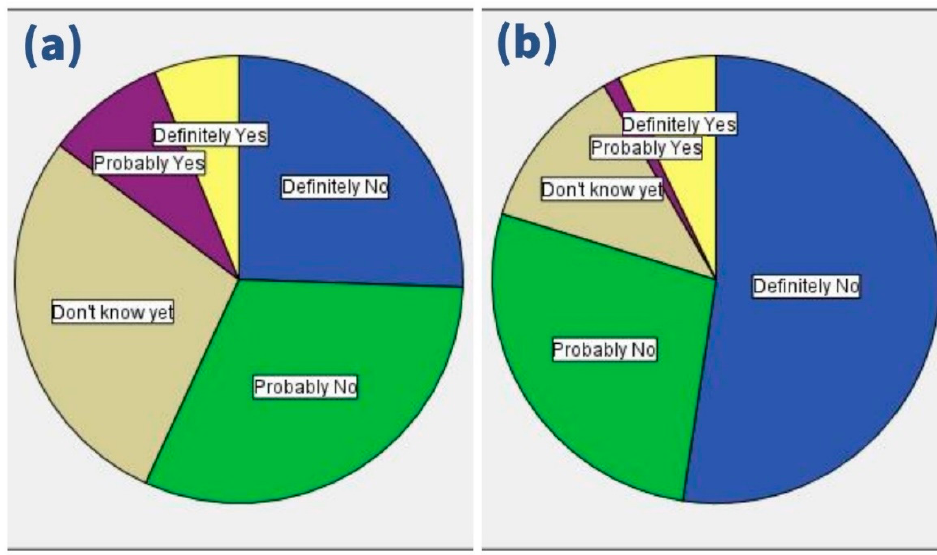
Figure 4. Response of ( a ) pregnant women and ( b ) lactating women to physician’s recommendation of COVID-19 vaccination, University Hospital Brno, August–October 2021 ( n = 362).